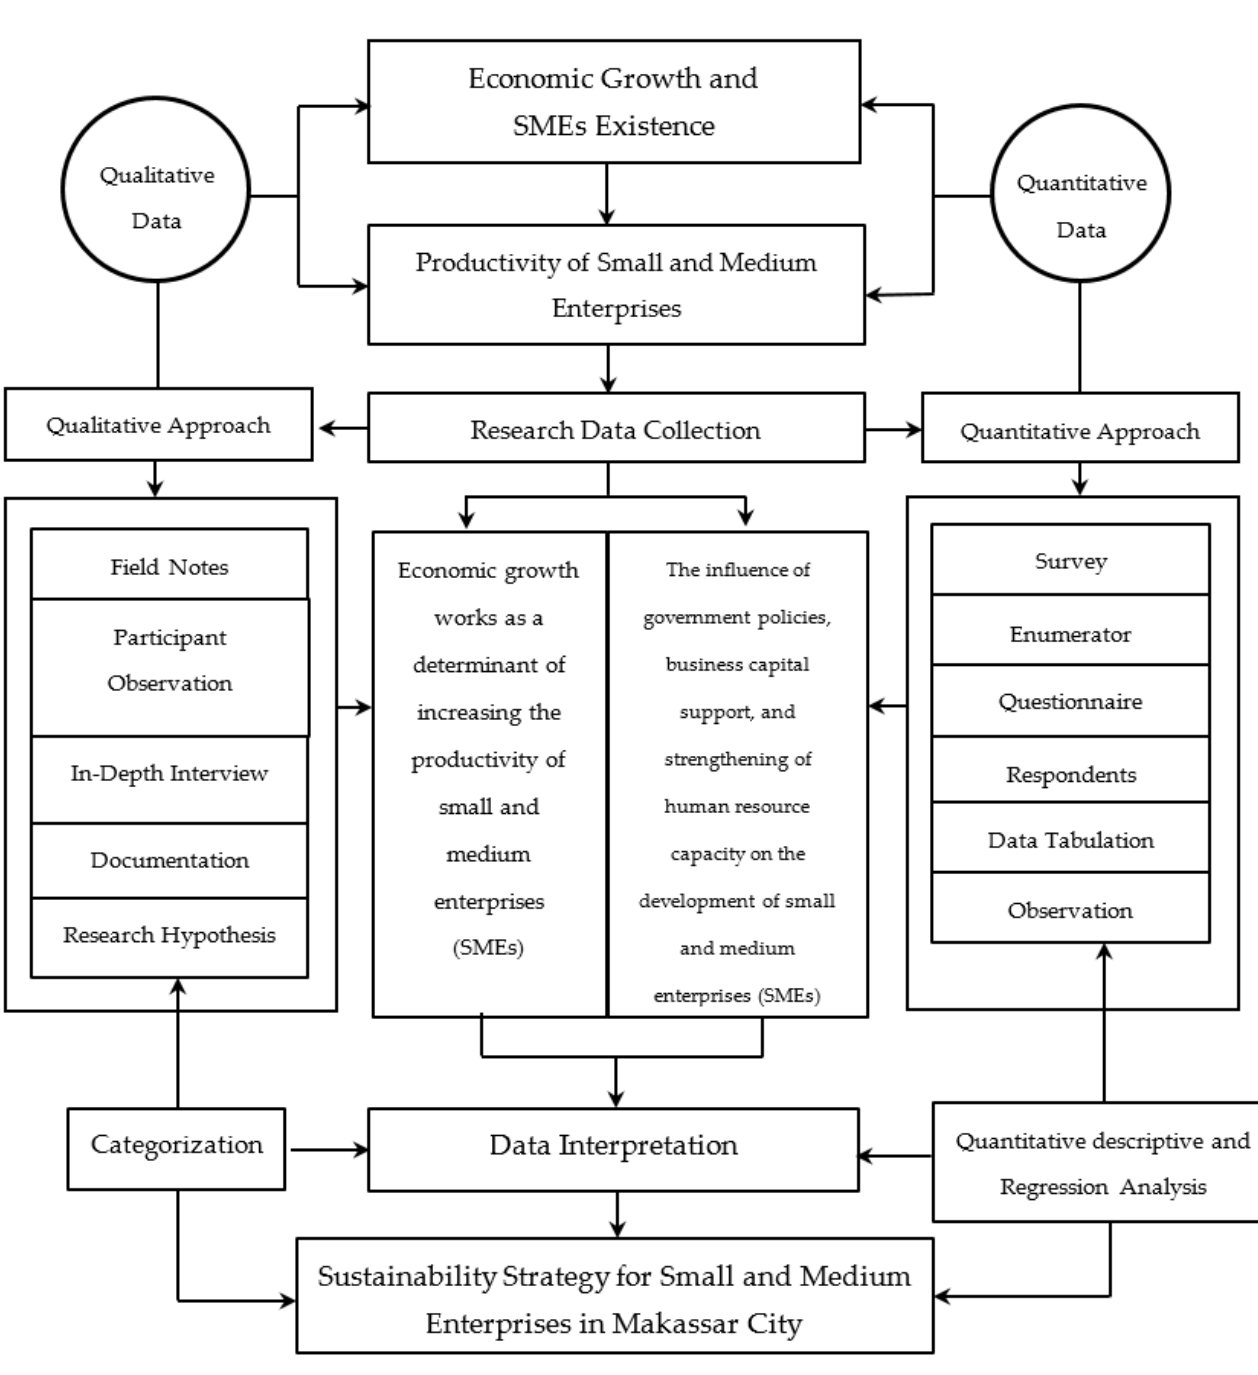
Figure 3. The process of combining qualitative and quantitative approaches. Source: author’s elaboration.